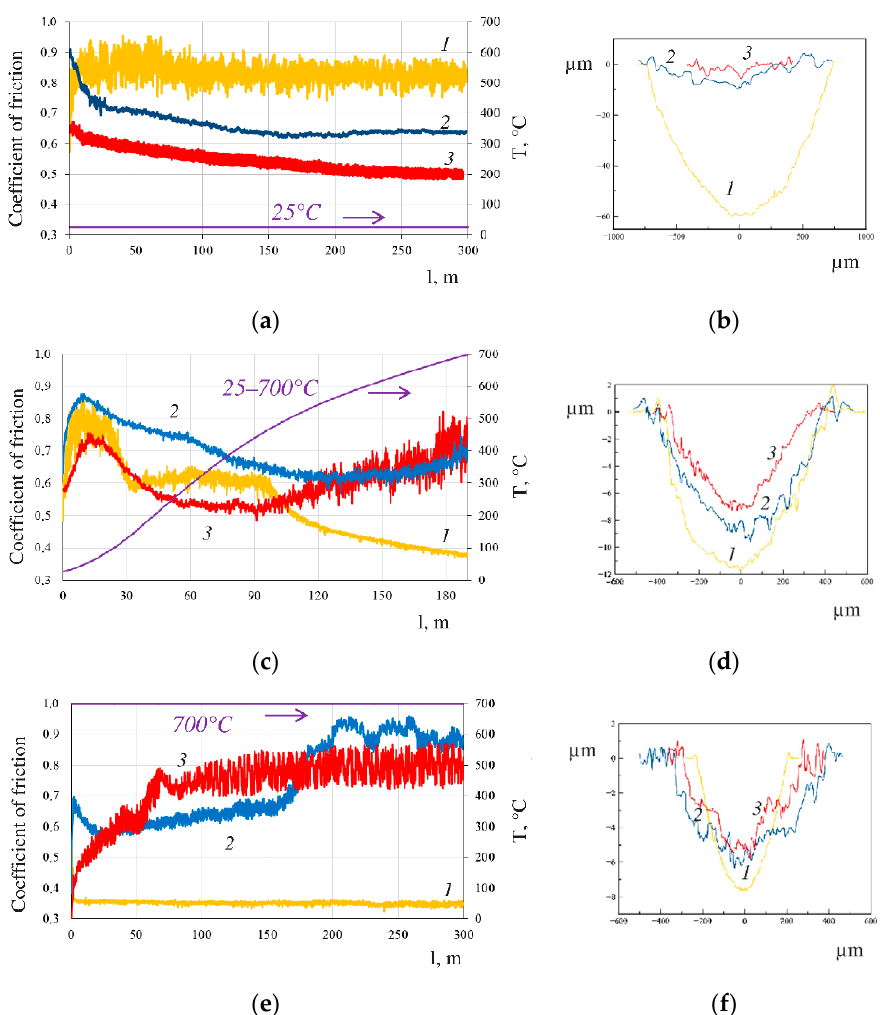
Figure 7. Friction coefficient of the samples at different temperatures as a function of distance ( a , c , e ) and the respective wear track profiles ( b , d , f ): 1—uncoated substrate; 2—as-deposited coating; and 3—annealed coating.